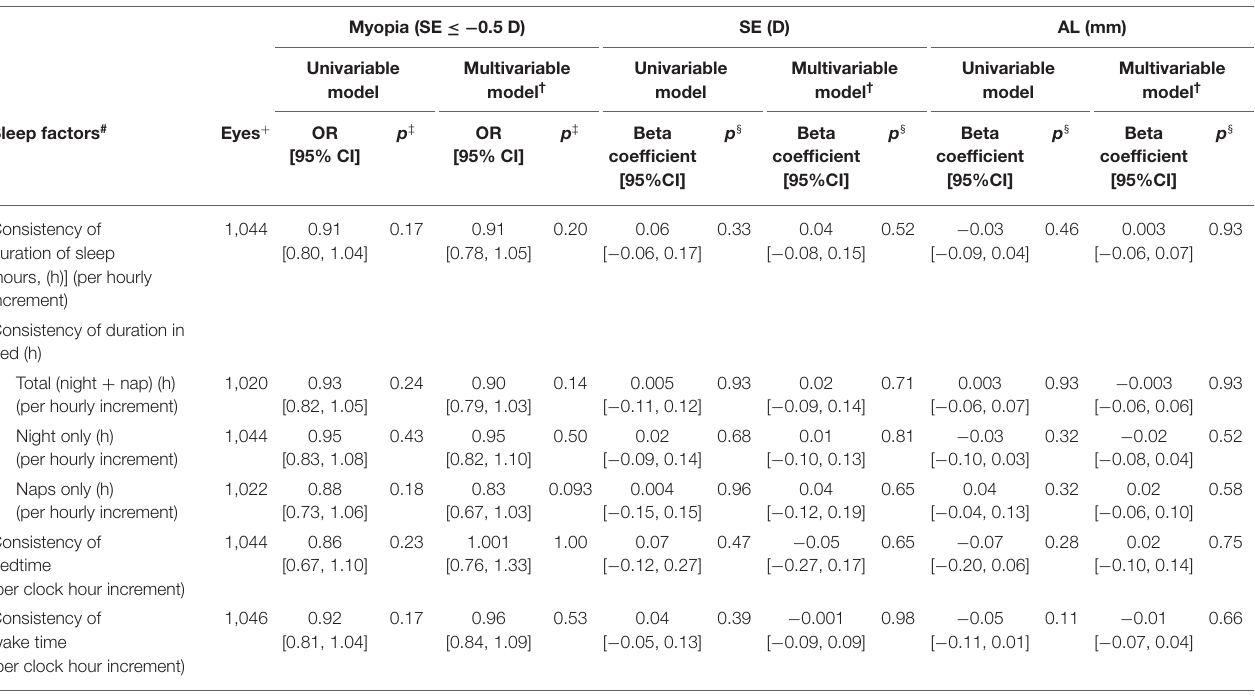
TABLE 3 | Associations of the consistency of sleep duration and timing with myopia (SE ≤ − 0.5 D), spherical equivalent (D) and axial length (mm) in children from the Growing Up in Singapore Towards healthy Outcomes (GUSTO) cohort ( n =